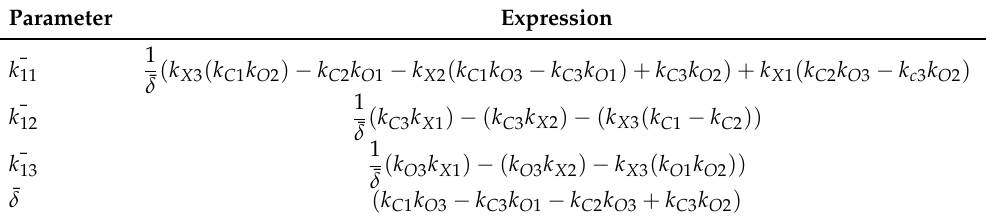
Table 3. Theoritical dependency of ¯ k ij